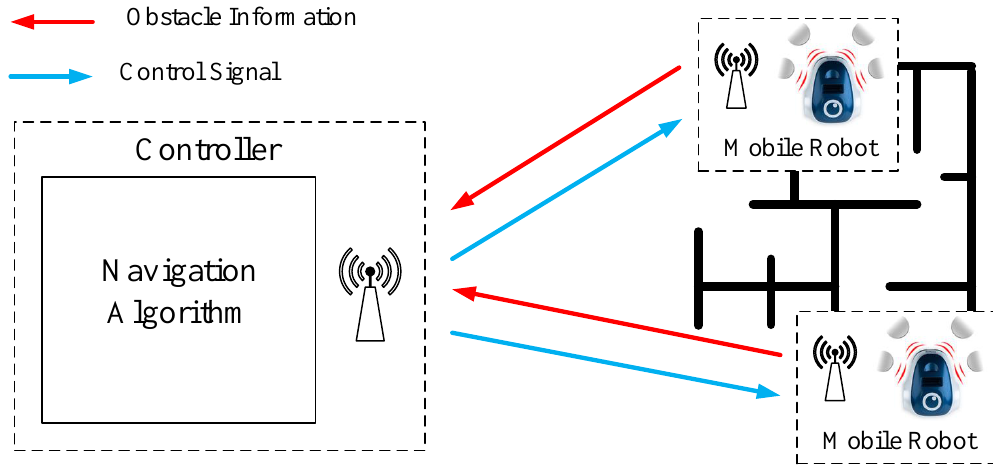
Figure 5. Navigation algorithm implementation based on centralized